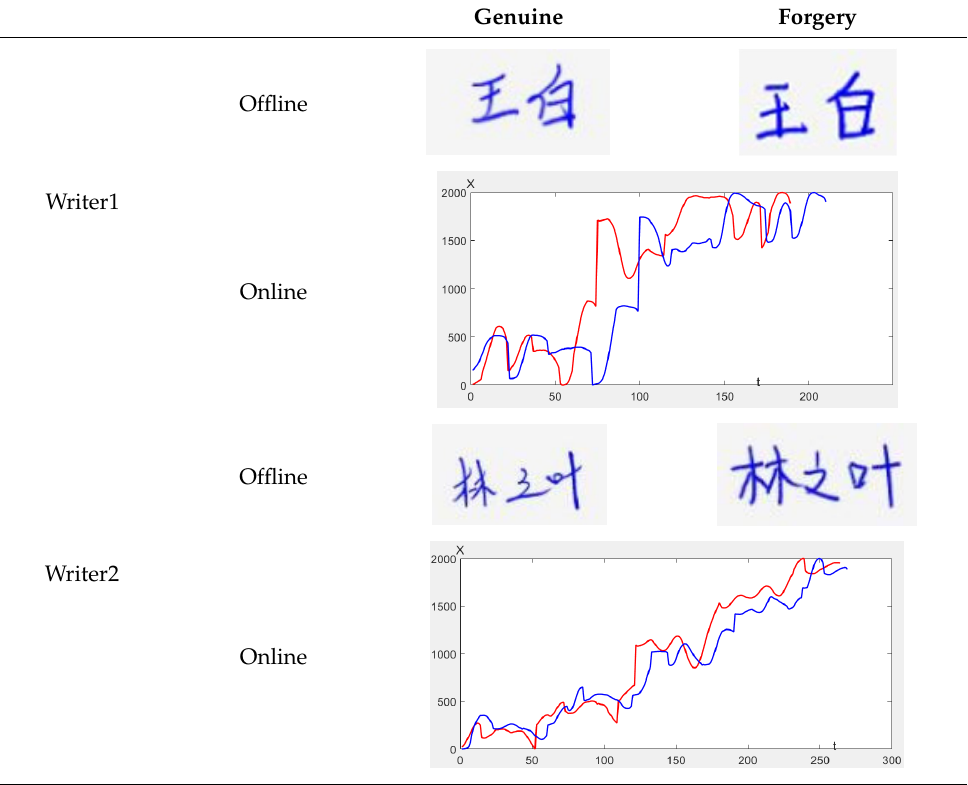
Table 1. Signature data.